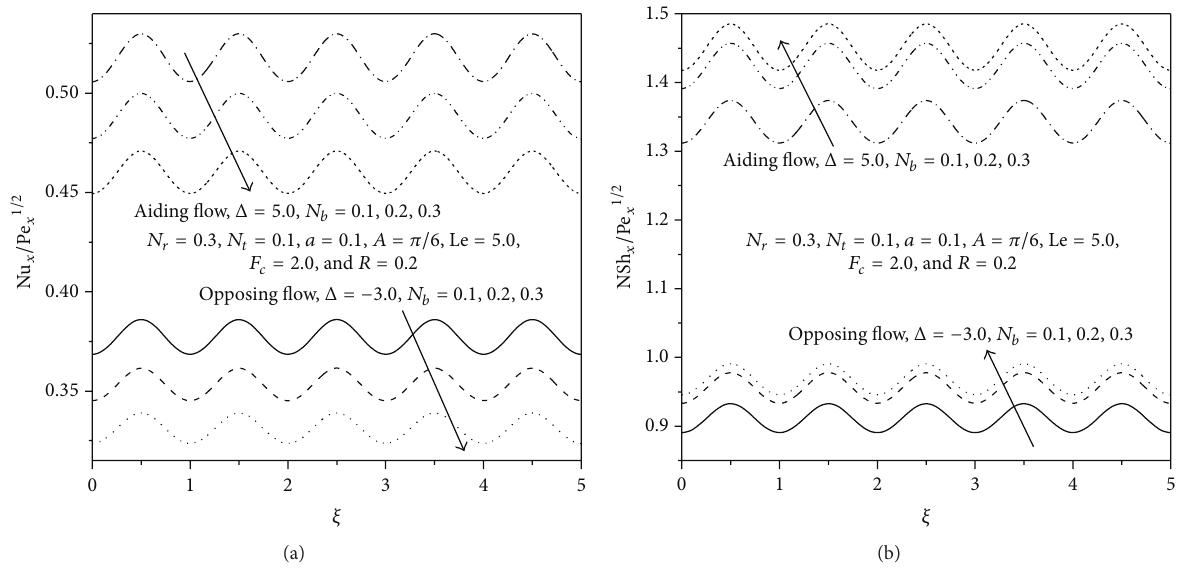
Figure 8: Effect of the Brownian motion parameter ( 𝑁 𝑏 ) on the heat and nanoparticle mass transfer rates.